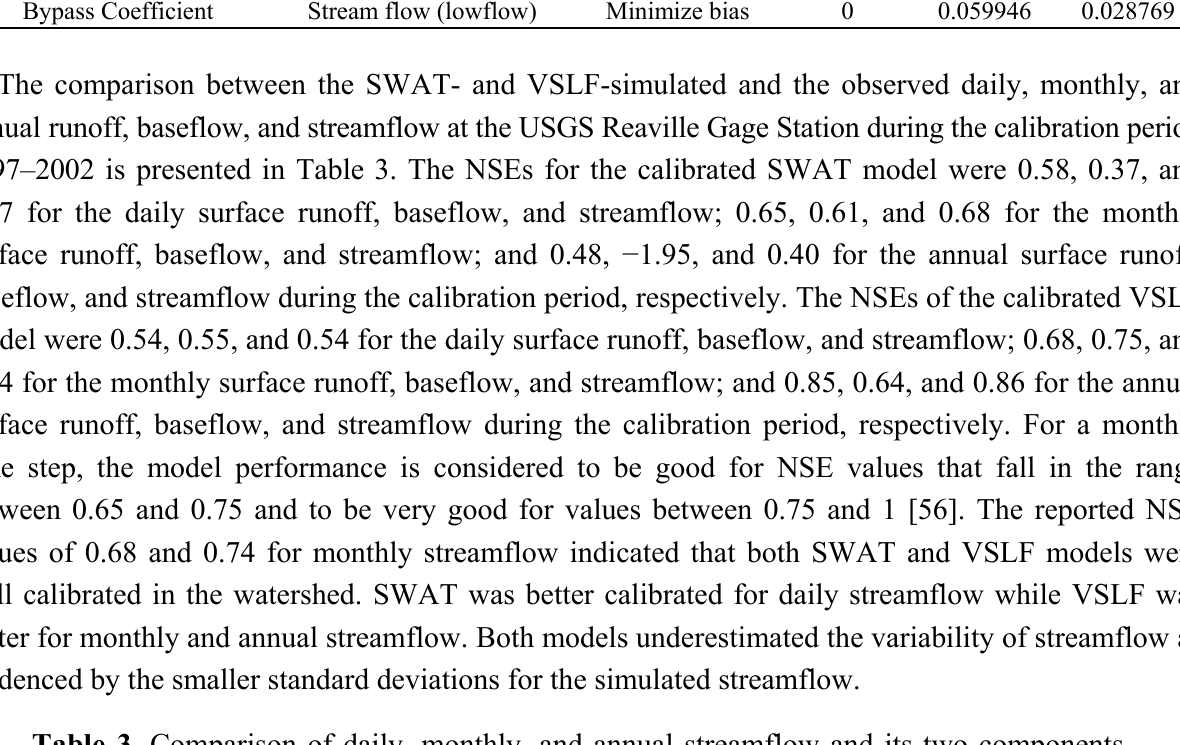
Table 3. Comparison of daily, monthly, and annual streamflow and its two components, surface runoff and baseflow, during the calibration period